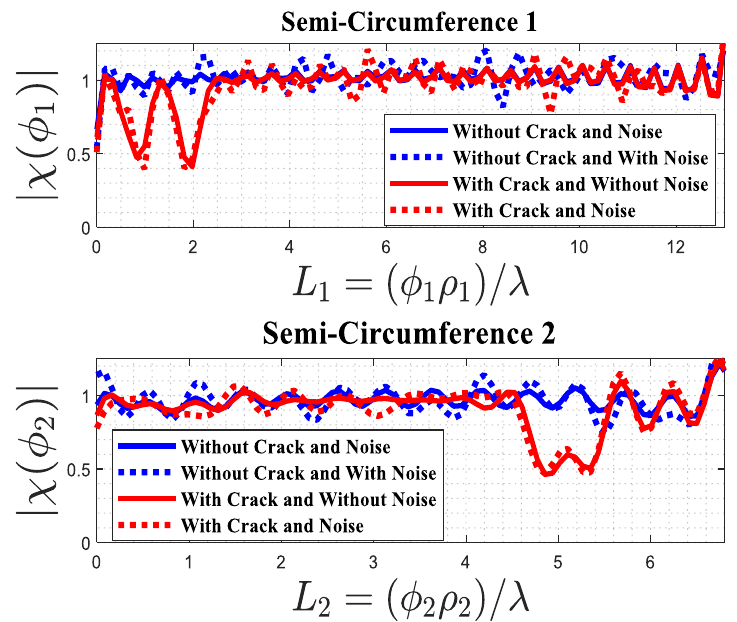
Figure 20. The reconstructions of the two semi-circumferences.